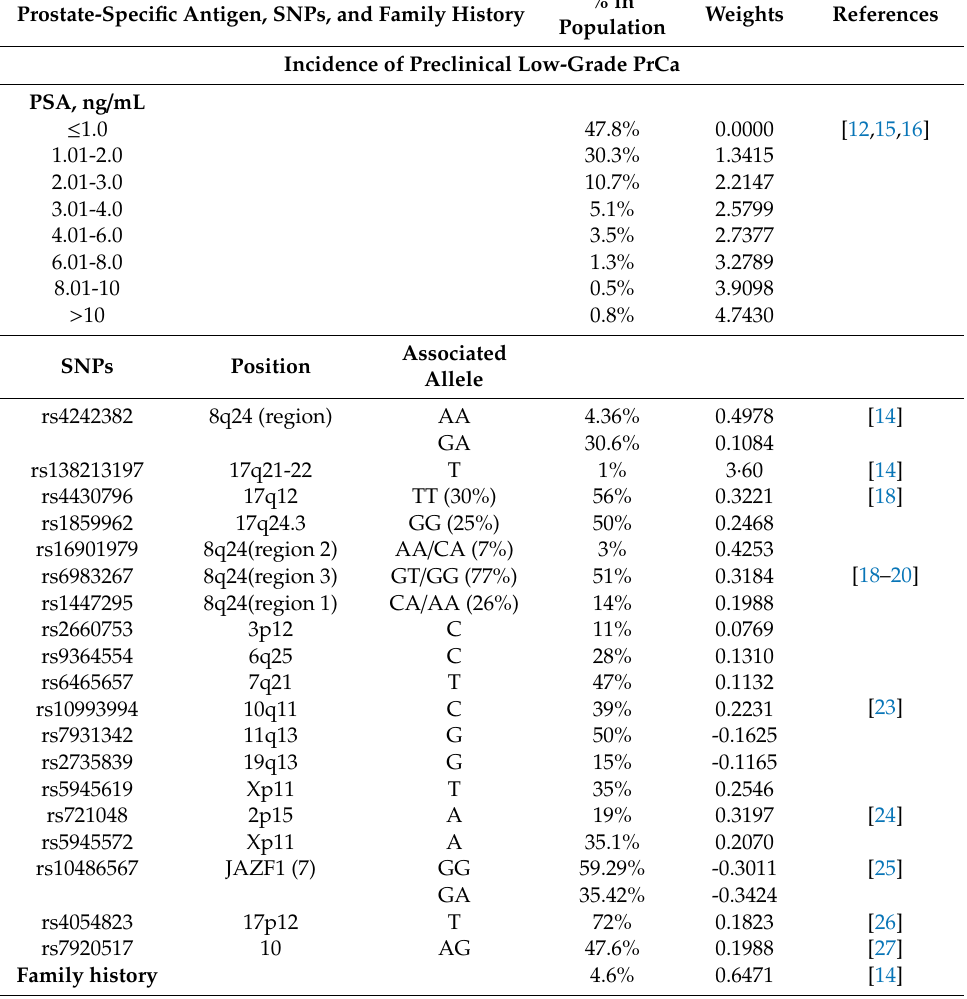
Table 1. The distribution in population and weights for the risk of incidence and aggressiveness of prostate cancer by PSA levels, selected SNPs, and family history. Prostate-Specific Antigen, SNPs, and Family